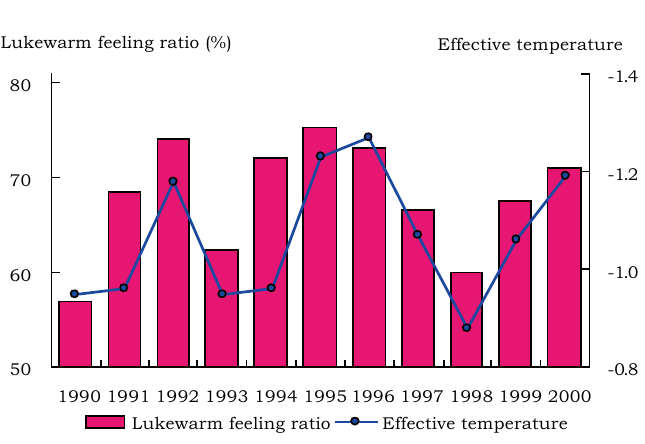
Figure 2. The changes in the lukewarm feeling ratio and effective